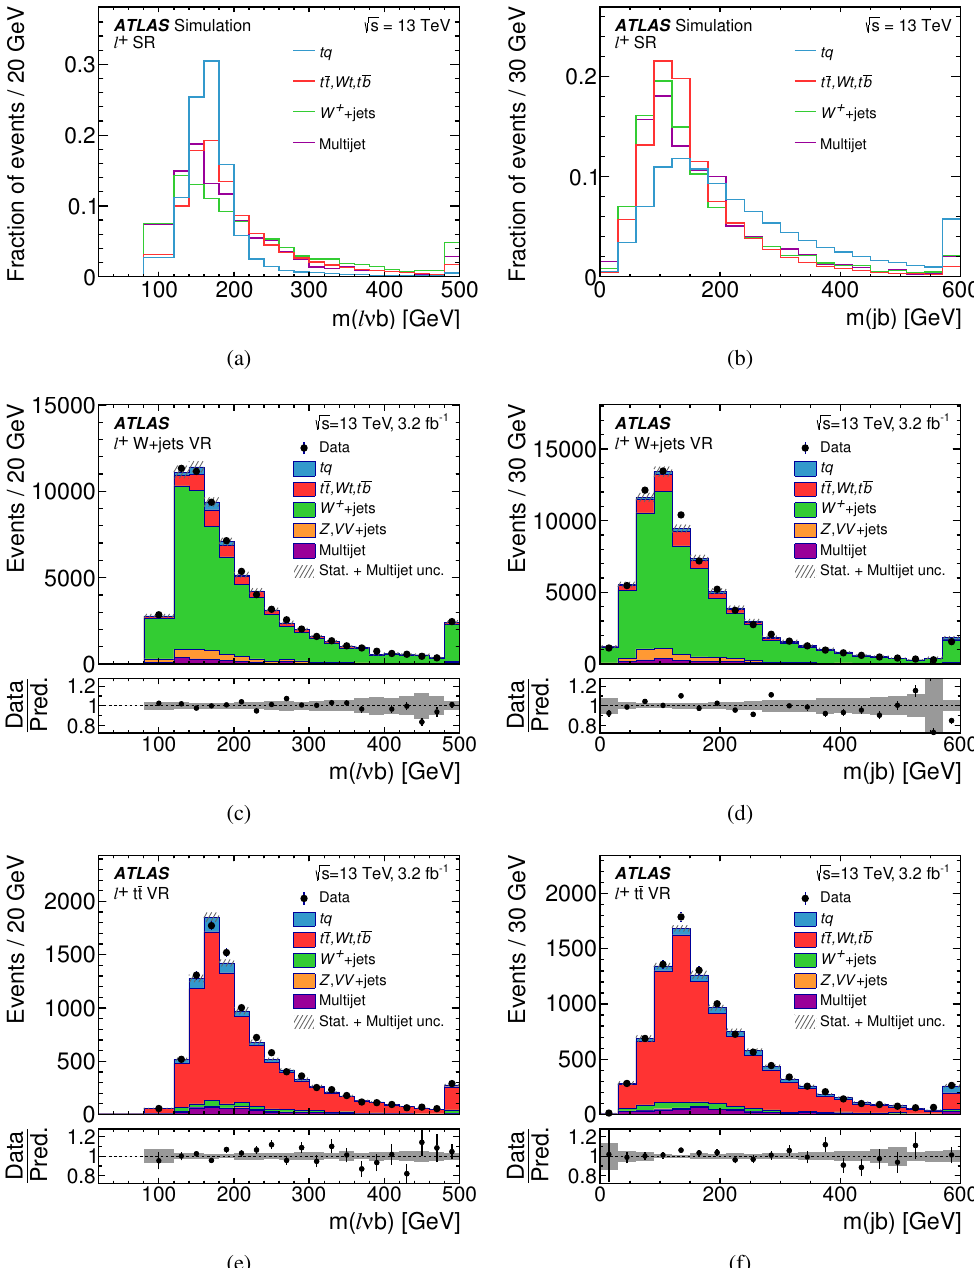
Figure 2 . Distributions of the two most discriminating variables, (left) the reconstructed top-quark mass m ( ‘(cid:23) b ) and (right) the invariant mass of the jet pair m ( jb ), for the ‘ + channel. In the t ¯ t VR the b -jet used to calculate m ( l (cid:23) b ) and m ( jb ) is the b -jet with the higher p T . (a)-(b): signal and background distributions normalised to unit area. (c)-(f): observed distributions in the W + jets VR and the t ¯ t VR compared to the model obtained from simulated events. The simulated distributions are normalised to match the number of observed events as described in the main text. The hatched and grey error bands represent the uncertainty in the number of multijet events and the uncertainty due to the size of the MC samples. The ratio of observed to predicted (Pred.) number of events in each bin is shown in the lower distributions. Events in the overflow are contained in the last